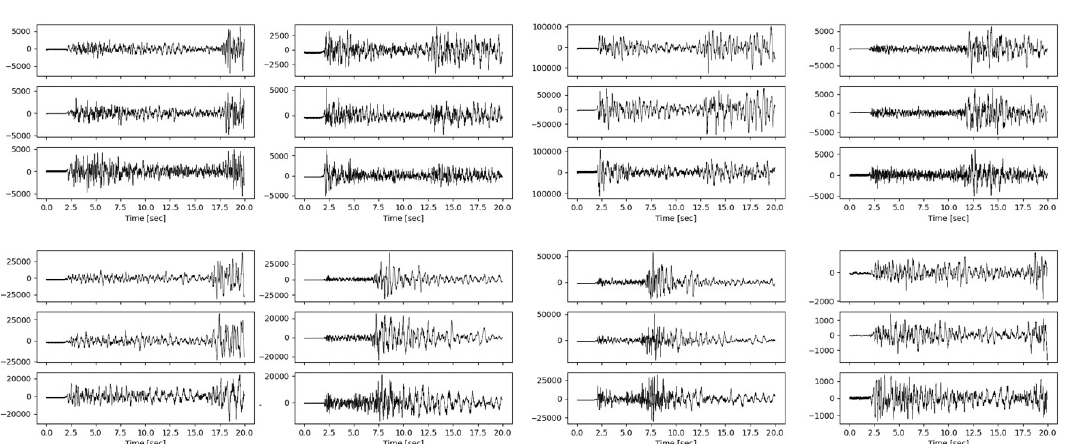
Figure 7. Samples of synthetic seismic waveforms generated by our